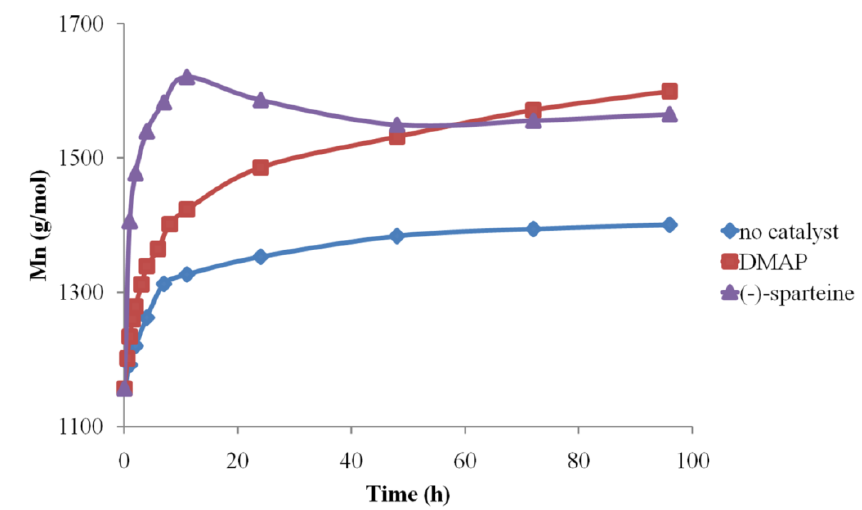
Figure 10. Organocatalyst influence in DMSO over M n evolution (#1, 2, 3).